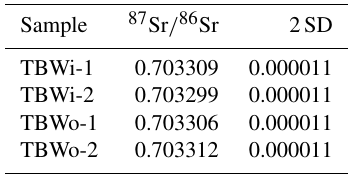
Table 2. 87 Sr / 86 Sr from aliquots of the Turkana dolomite run by thermal ionization mass